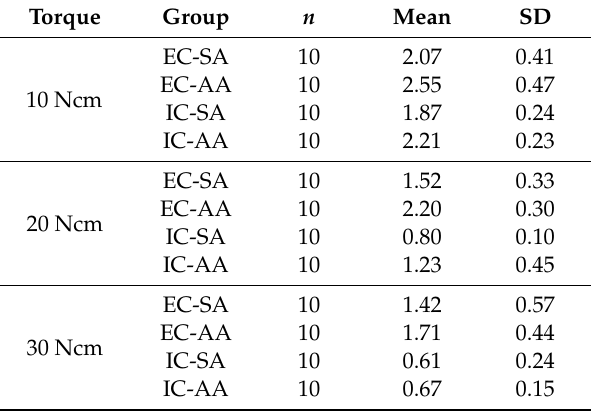
Table 7. Means and standard deviations (SD) misfit values (micrometers) for each group according to the tightening torque applied (EC: external connection; IC: internal connection; SA: straight abutment; AA: angulated